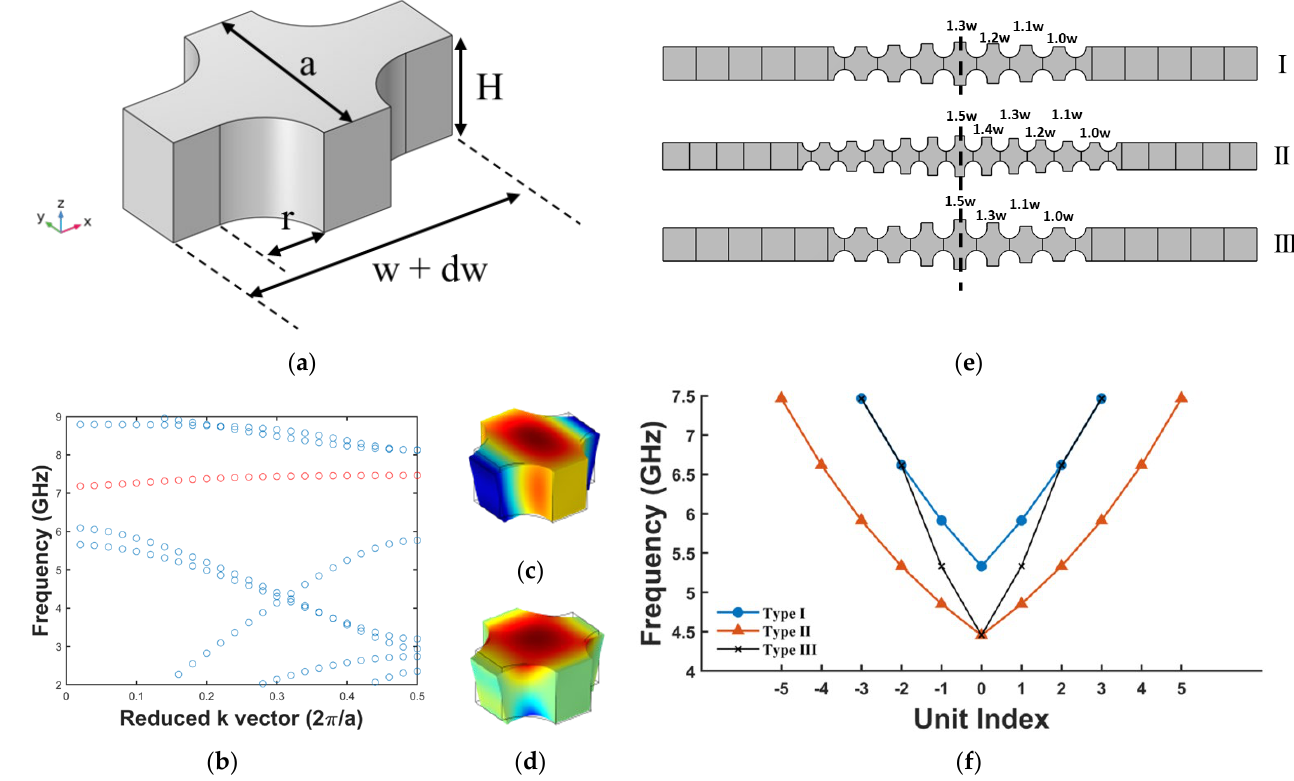
Figure 1. Sketches of ( a ) the fishbone unit cell with the geometric parameters and ( b ) the band structure with the SS mode marked by red circles. ( c ) The out-of-plane displacement field and ( d ) the strain field of the SS mode in ( b ). ( e ) A sketch of three types of the APW fishbone structures and ( f ) their APW display as blue circles (type-I), orange triangles (type-II), and black crosses (type-III). Table 1. The eigenfrequencies of the SS mode in the fishbone unit cells with different values of dw. a = 440